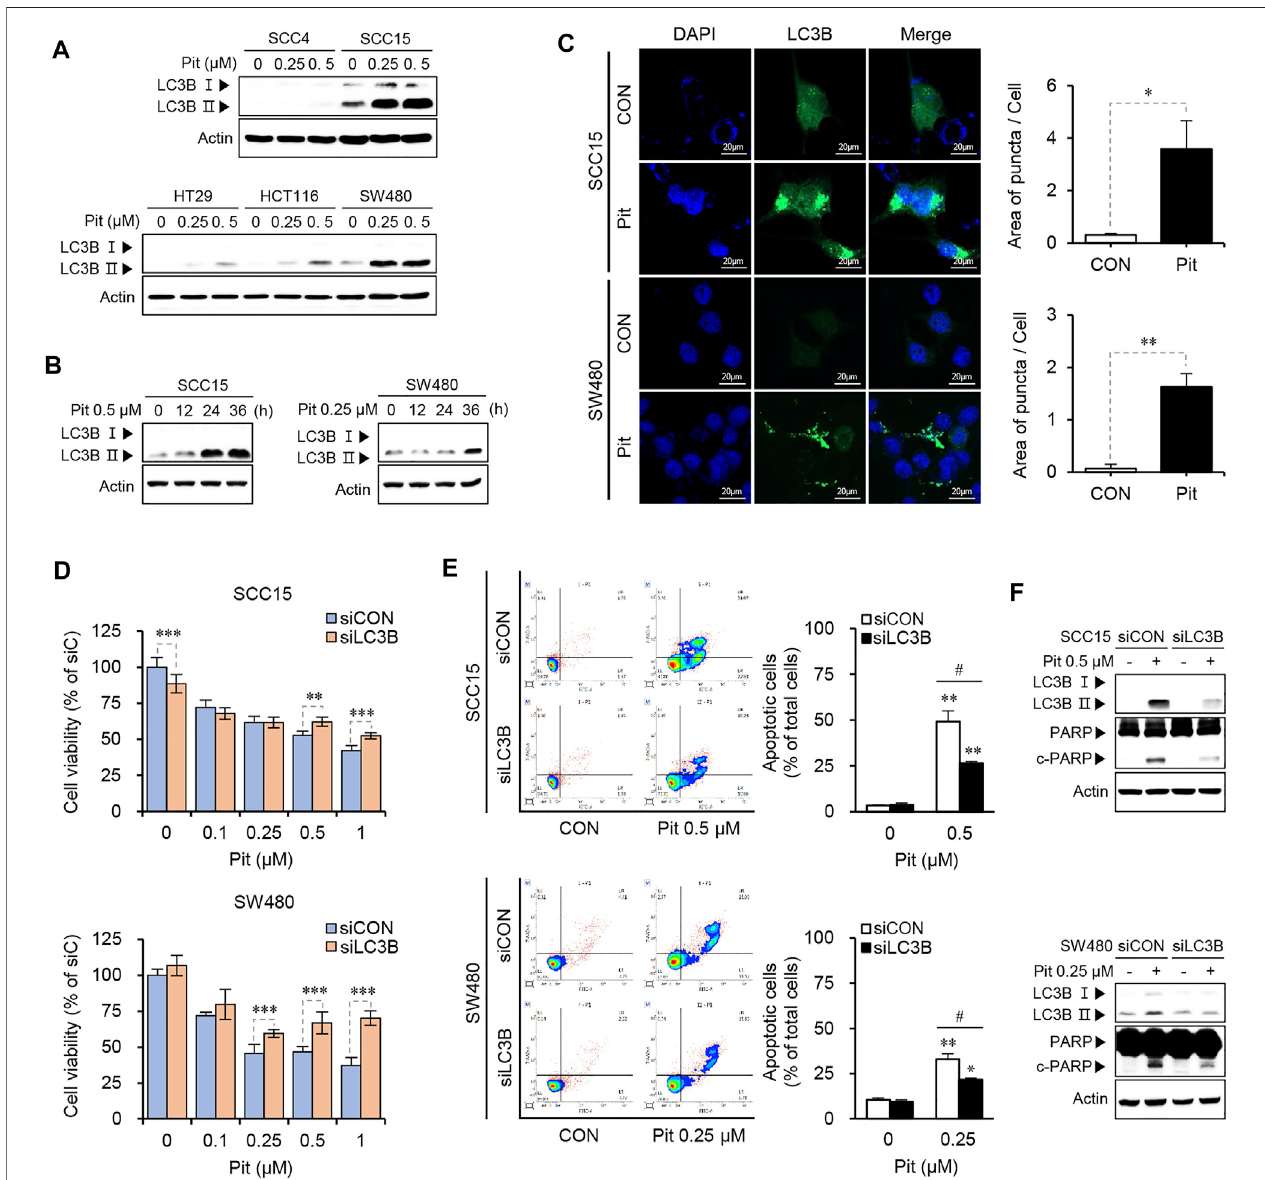
FIGURE 2 | Pitavastatin induces autophagy-dependent apoptosis in SCC15 and SW480 cells. (A,B) Cells were treated with pitavastatin as indicated. The expressions of LC3B-I and LC3B- II proteins were detected using western blot analysis. Actin was used as the loading control. (C) SCC15 and SW480 cells seeded on sterile coverslips were transfected with GFP-LC3 plasmid for 24 h, followed by treatment with or without pitavastatin for 36 h, and the formation of autophagosomes (green puncta) was analyzed by confocal microscopy. The histograms show the quanti fi cation of GFP puncta, quantitated using the ImageJ software. Statistical analysis was performed using the Student ’ s t -test. Error bars represent mean ± SD ( n = 3). * p < 0.05; ** p < 0.01. (D) SCC15 and SW480 cells plated on 96-well plates were transfected with LC3B siRNA in the presence or absence of the indicated concentrations of pitavastatin for 48 h. Cell viability was then measured using the CytoTox-Glo cytotoxicity assay. Statistical analysis was performed using two-way ANOVA. Error bars represent mean ± SD ( n = 4). ** p < 0.01; *** p < 0.001. (E) Flow cytometry analysis was performed to evaluate the effect of siLC3B on the apoptosis of SCC15 and SW480 cells. Statistical analysis was performed using the Student ’ s t -test. Error bars represent mean ± SD ( n = 3). * p < 0.05; ** p < 0.01; # p < 0.05. (F) After transfection with LC3B siRNA, cells were further incubated for 24 h in the presence or absence of pitavastatin. The protein levels were measured by western blot analyses.